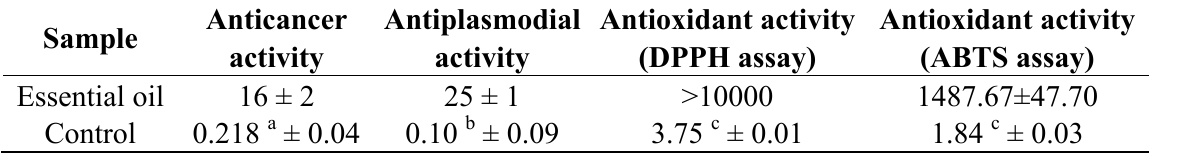
Anticancer, antimalarial and antioxidant activities (IC50 (mg/L))